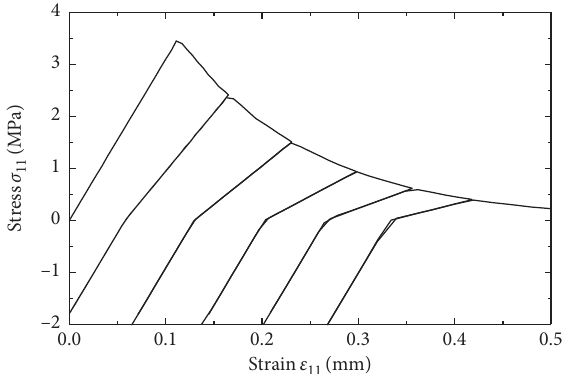
Figure 6: Stress-strain curve of tension compression